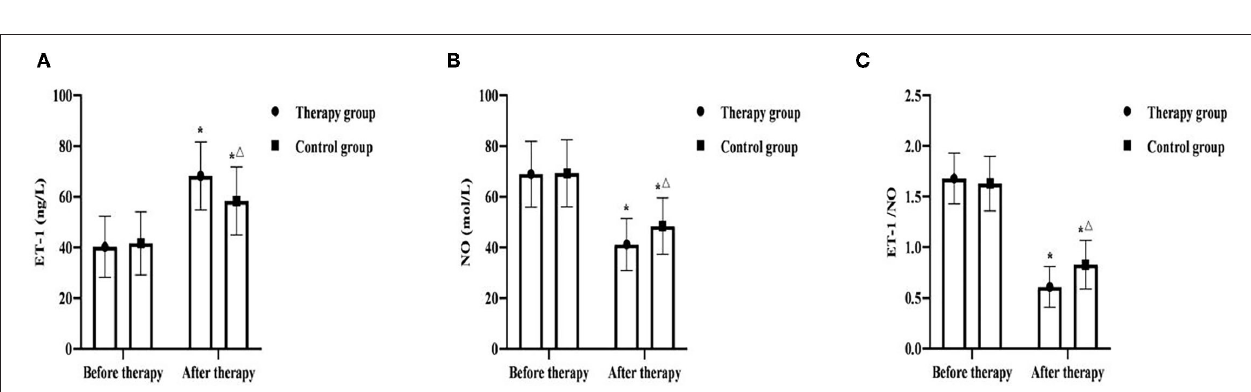
FIGURE 4 | Comparison of vascular endothelial function between the two groups ( x ± s , n = 55). (A) was comparison of ET-1 between the two groups. (B) was comparison of NO between the two groups. (C) was comparison of ET-1/NO between the two groups. * P < 0.05 was compared with the same group before therapy, 1 P < 0.05 was compared with the control group after